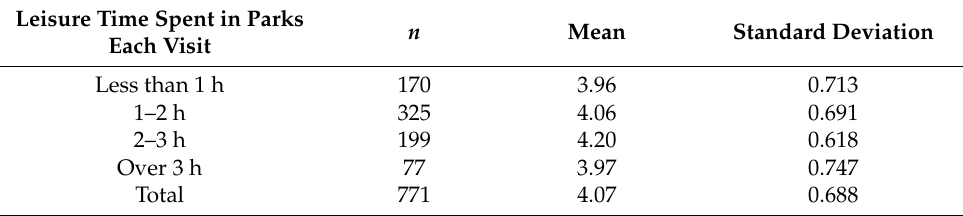
Table 10. Differences in the effects of leisure time spent in parks each visit on leisure benefits. Leisure Time Spent in Parks n Mean Standard Deviation Each Visit Less than 1 h 170 3.96 0.713 1–2 h